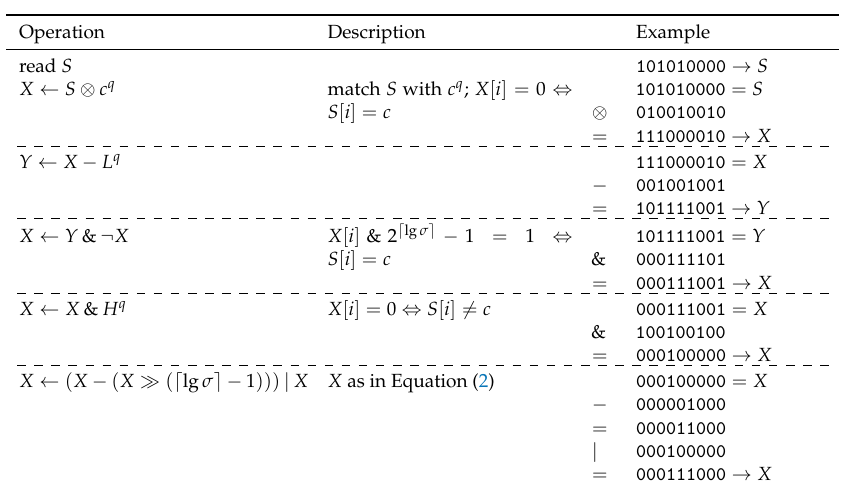
Figure 4. Matching all occurrences of a character in a string S fitting into a computer word in constant time by using bit-parallel instructions. For the last step, special care has to be taken when the last character of S is a match, as shifting X (cid:100) lg σ (cid:101) bits to the right might erase a ‘1’ bit witnessing the rightmost match. In the description column, X is treated as an array of integers with bit width (cid:100) lg σ (cid:101) . In this example, S = 101010000 , c has the bit representation 010 with lg σ = 3, and q =